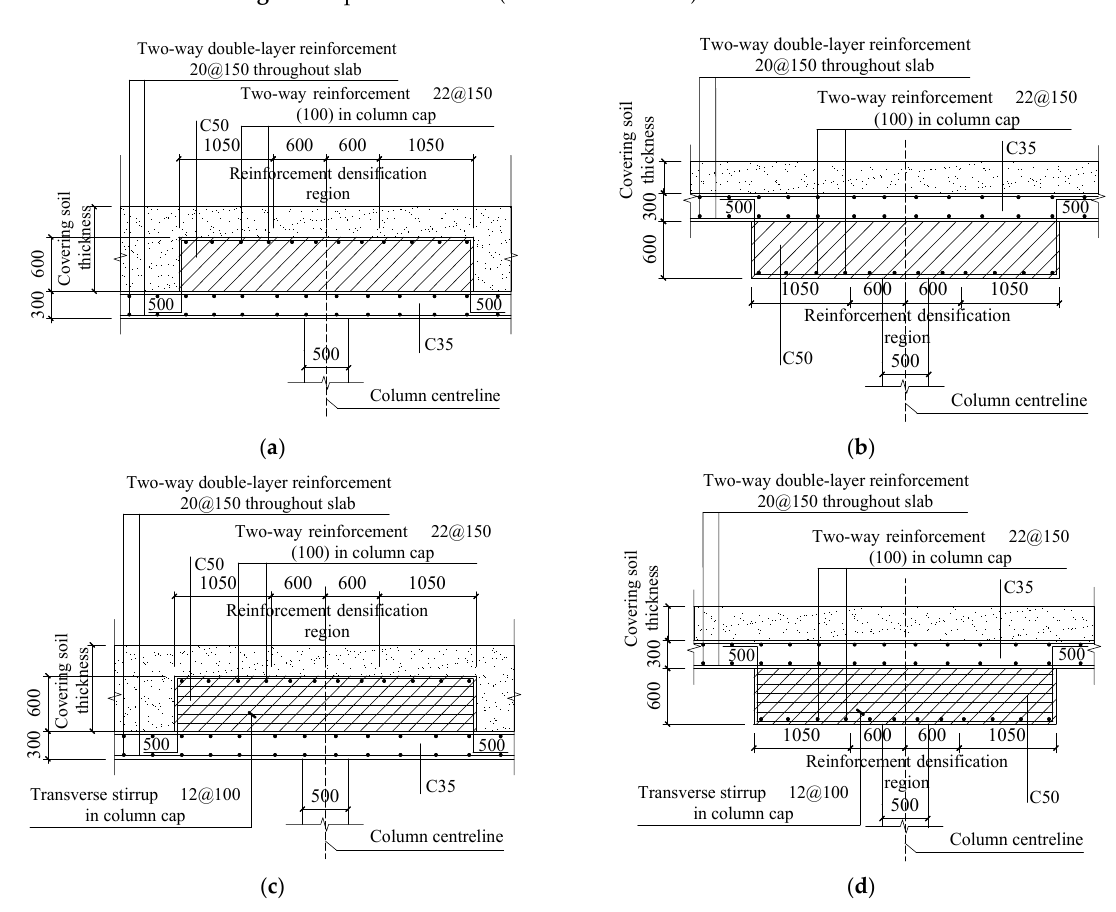
Figure 9. Reinforcement arrangements in specimens ZM01–ZM04 (dimensions in mm): ( a ) ZM01; ( b ) ZM02; ( c ) ZM03; ( d ) ZM04.